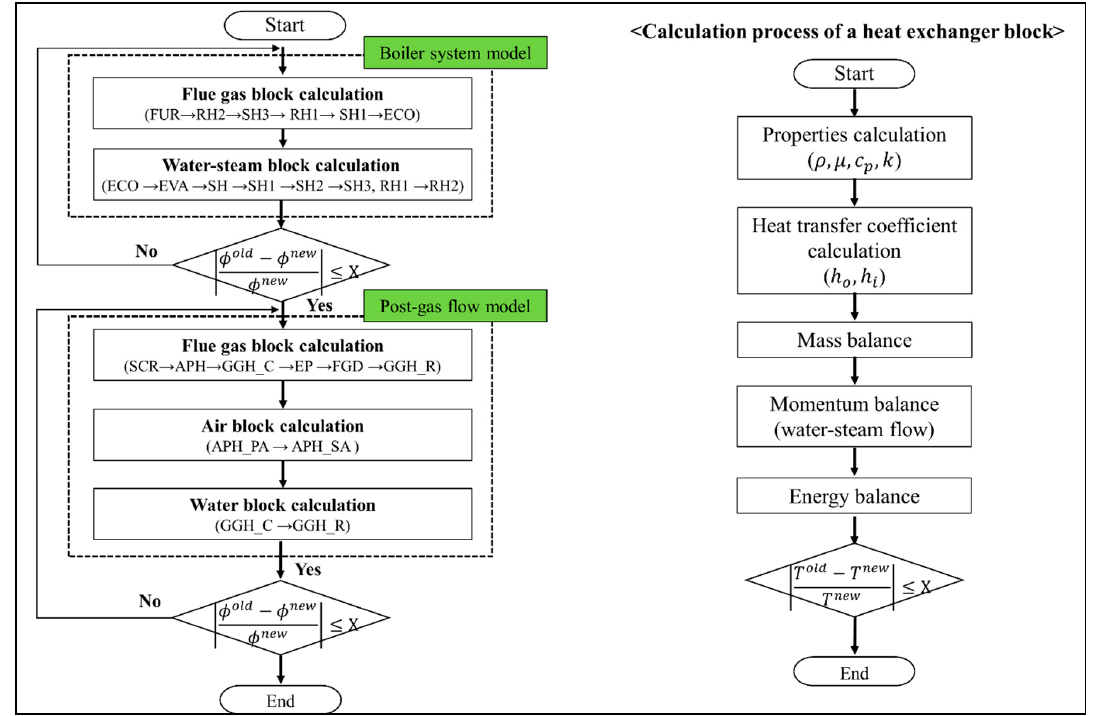
Figure A1. Calculation process for the entire process simulation model including each heat exchanger block model.